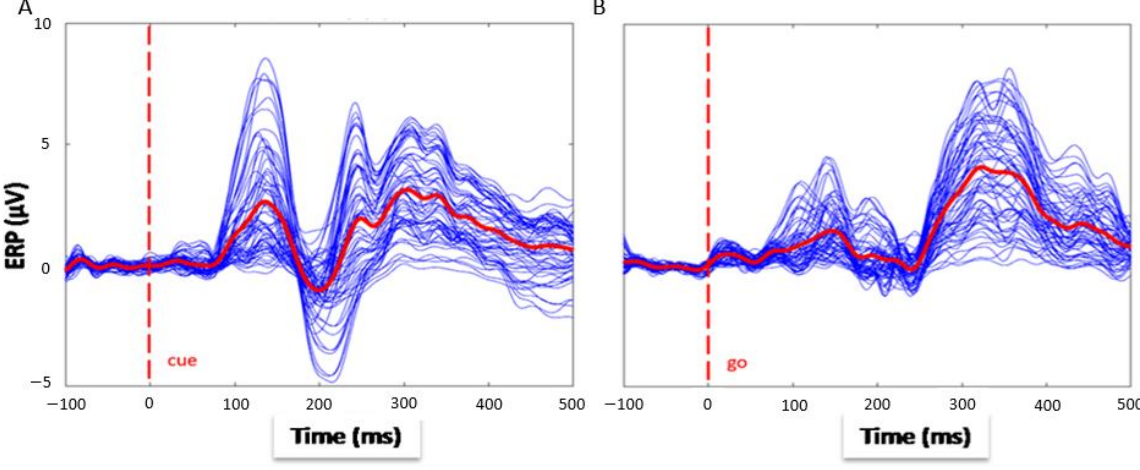
Figure 2. Butterfly plot of all channels and average trends (red lines) of ERP of a representative subject in the two conditions: the cue ( A ) and go ( B ) time intervals.